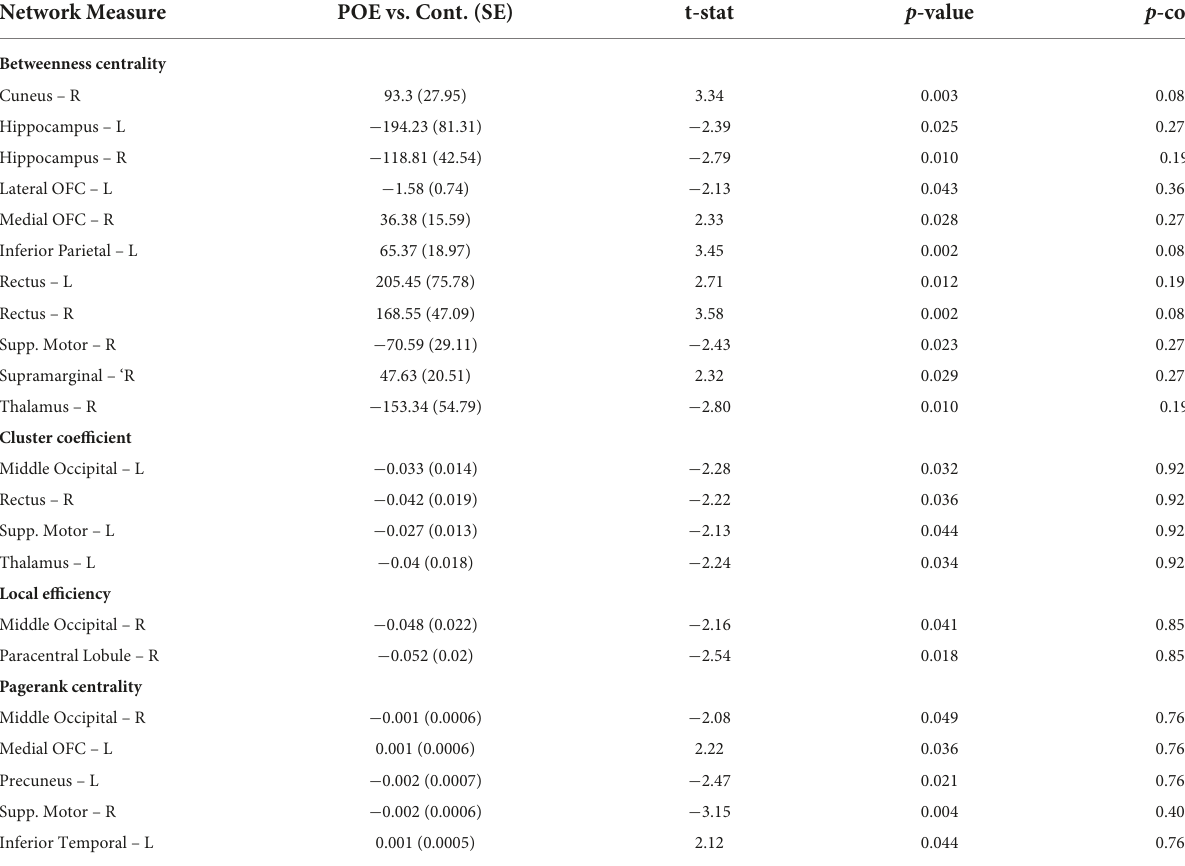
TABLE 5 Network measures between POE and opioid naïve infants based on fractional anisotropy (FA). Network Measure POE vs. Cont.